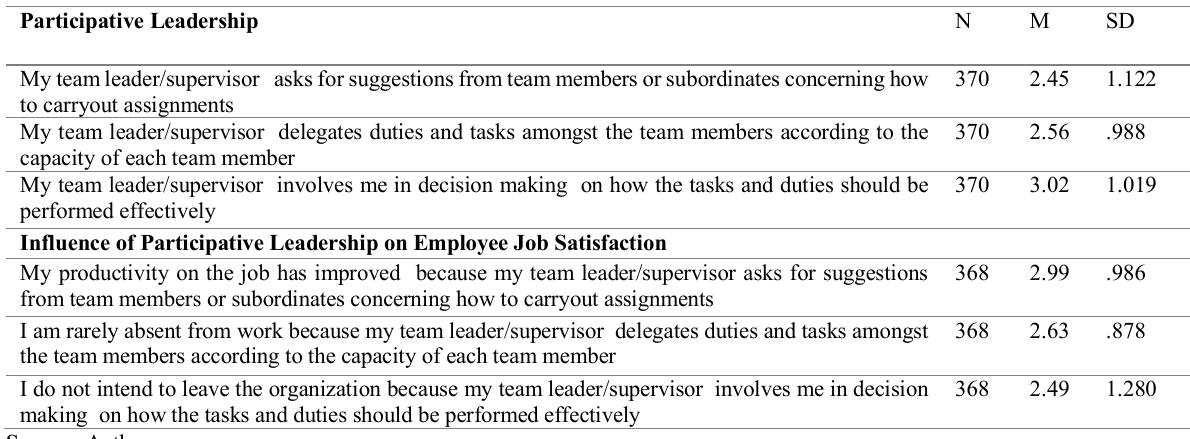
Table 1: Mean and standard deviation for participative leadership style